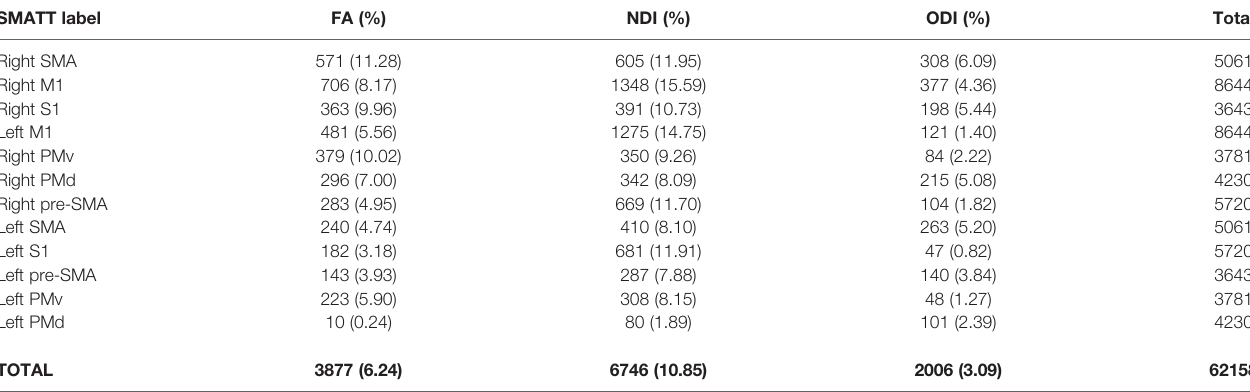
TABLE 2 | Number and percentage of voxels signi fi cantly differing between MS and HC in FA, NDI and ODI in SMATT regions. SMATT